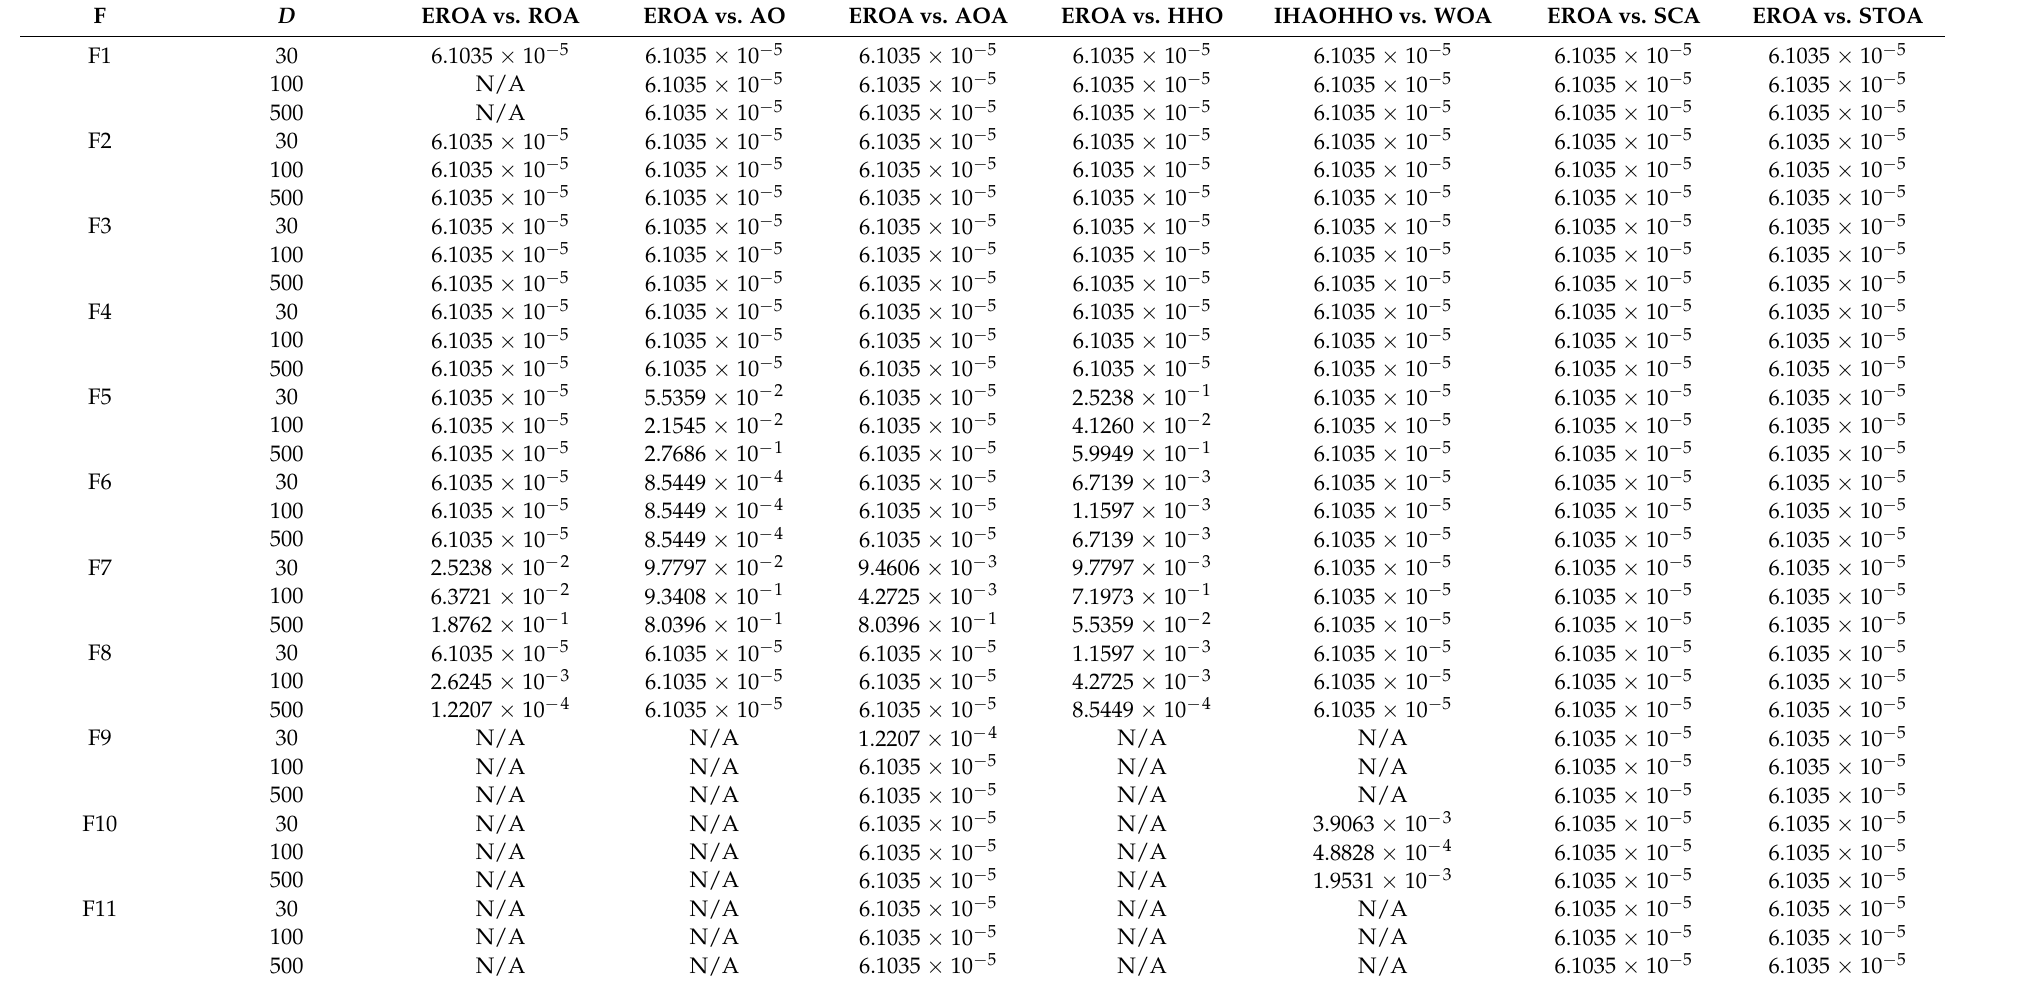
Table 6. p -Values from the Wilcoxon rank-sum test for the results in Table